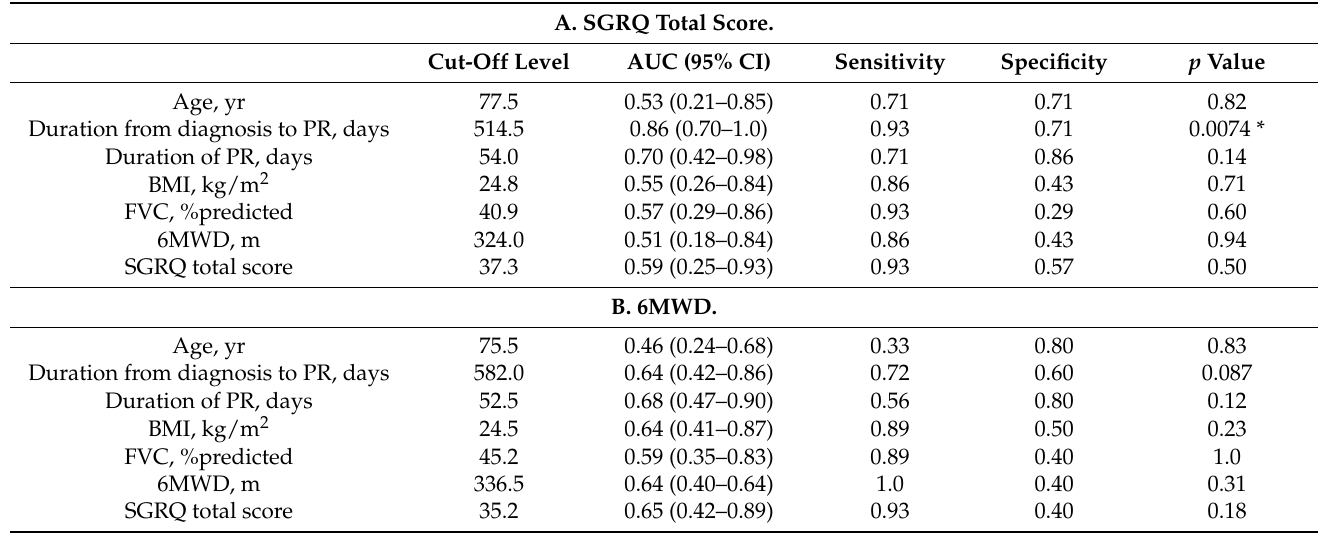
Table 5. Area under the curve for predicting improvement over MCID of ( A ) SGRQ total score and ( B ) 6MWD. A. SGRQ Total